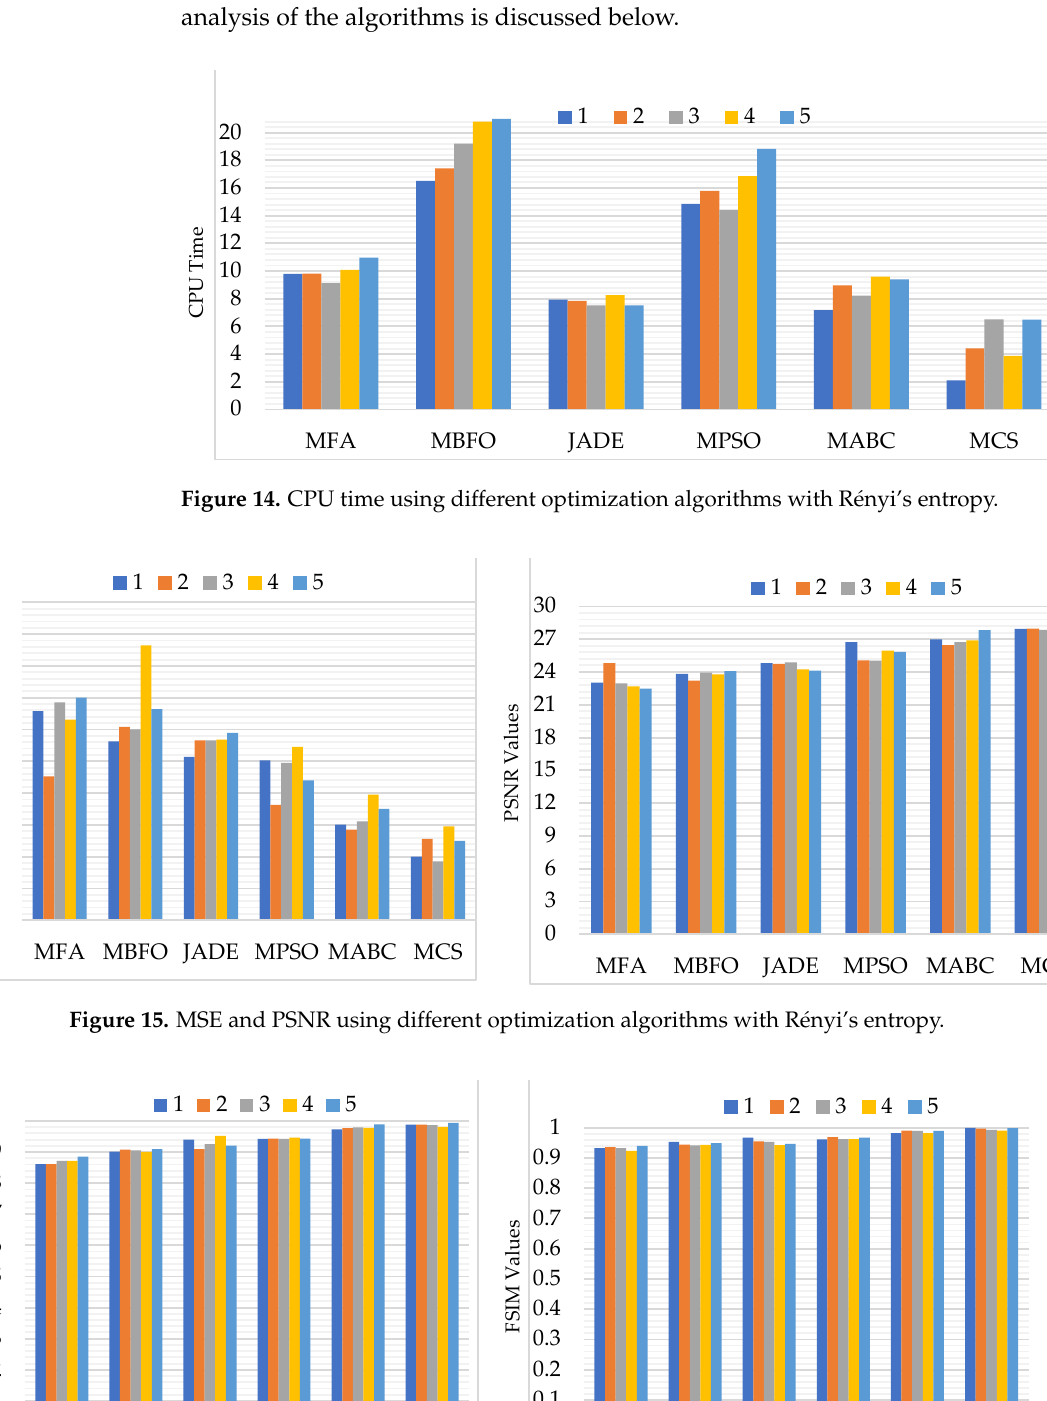
Figure 15. MSE and PSNR using different optimization algorithms with Rényi’s entropy. Table 10. MSE and PSNR using different optimization algorithms with Rényi’s entropy.